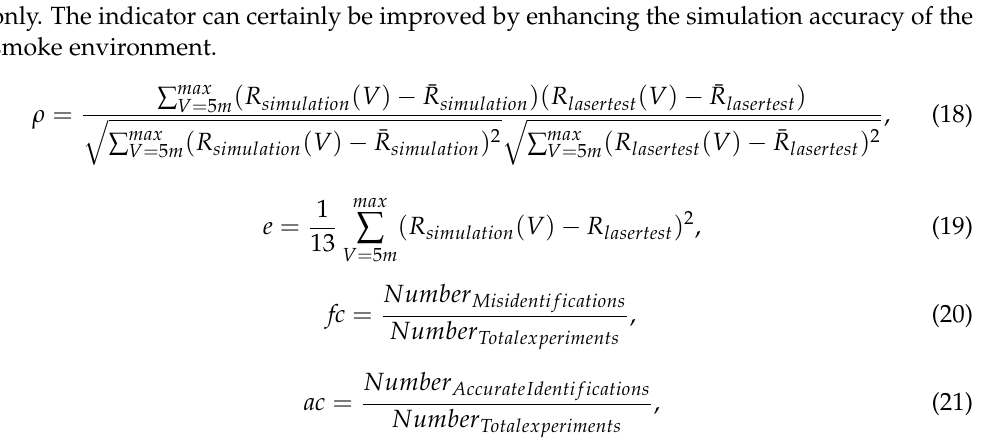
Table 1. Results of evaluation indicators between Monte-Carlo simulation and proposed method. Method